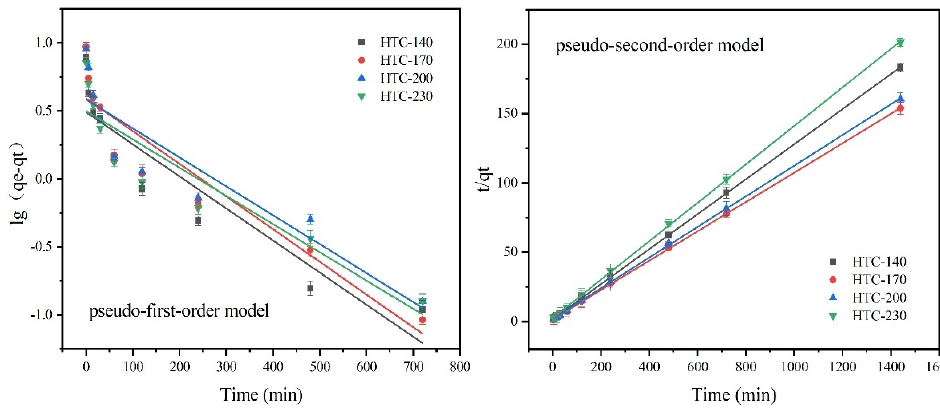
Figure 11. Adsorption kinetics of Cd 2+ on the hydrochar. Table 4. Kinetic parameters for the adsorption of Cd 2+ on the hydrochar.